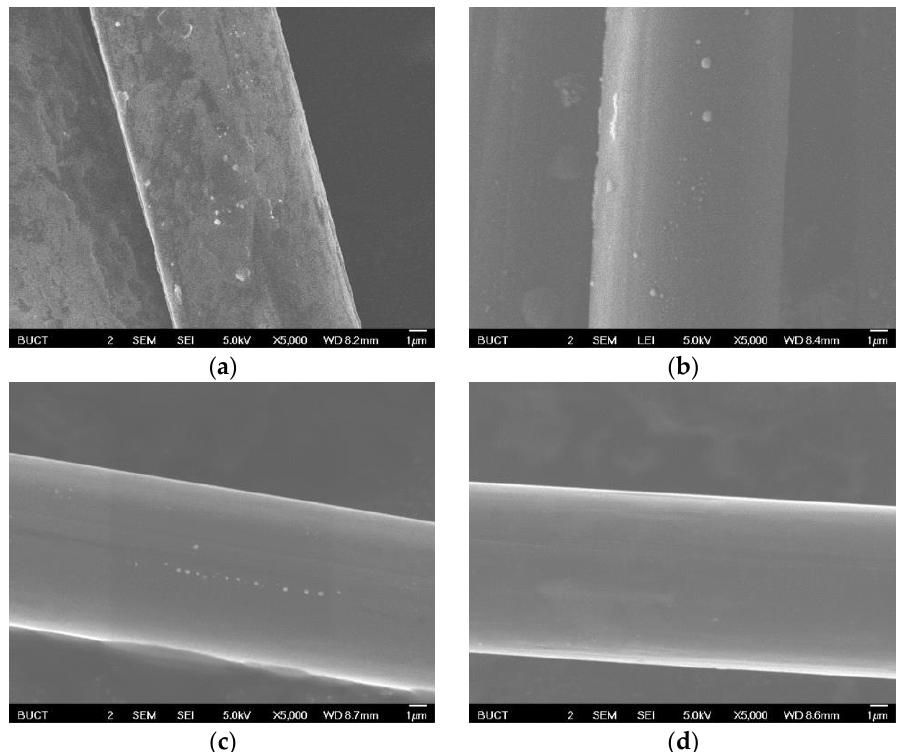
Figure 4. SEM images of each sample. ( a ) Untreated; ( b ) 700 °C-treated; ( c ) 900 °C-treated; ( d ) 1100 °C-treated.